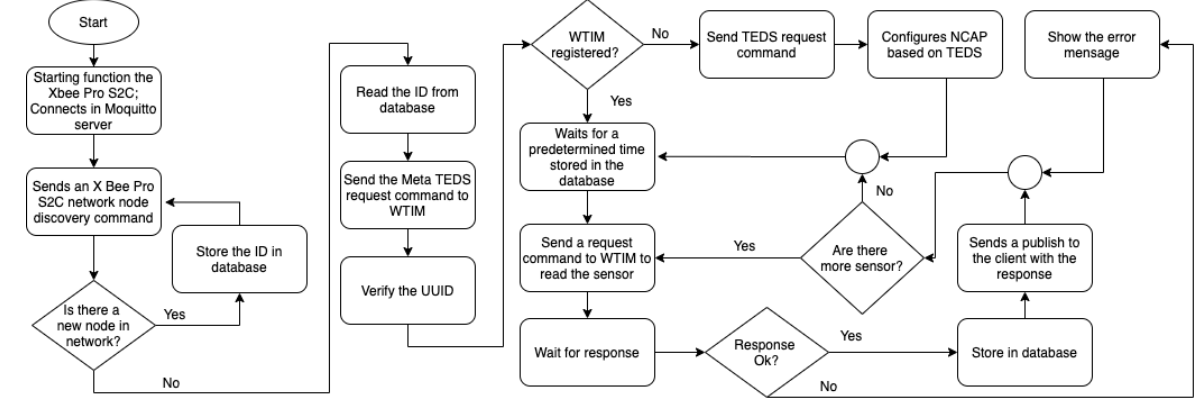
Figure 3. Flowchart of the logical part of the NCAP.